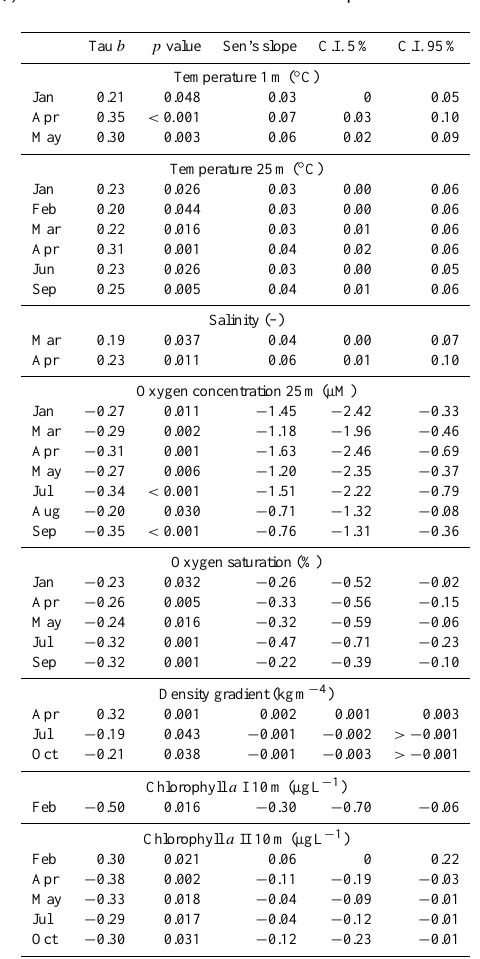
Table 2. Test statistics of monthly Mann–Kendall tests part I. Only significant results are shown. Tau b : Kendall coefficient for time se- ries including ties; Sen’s slope: median slope present in time